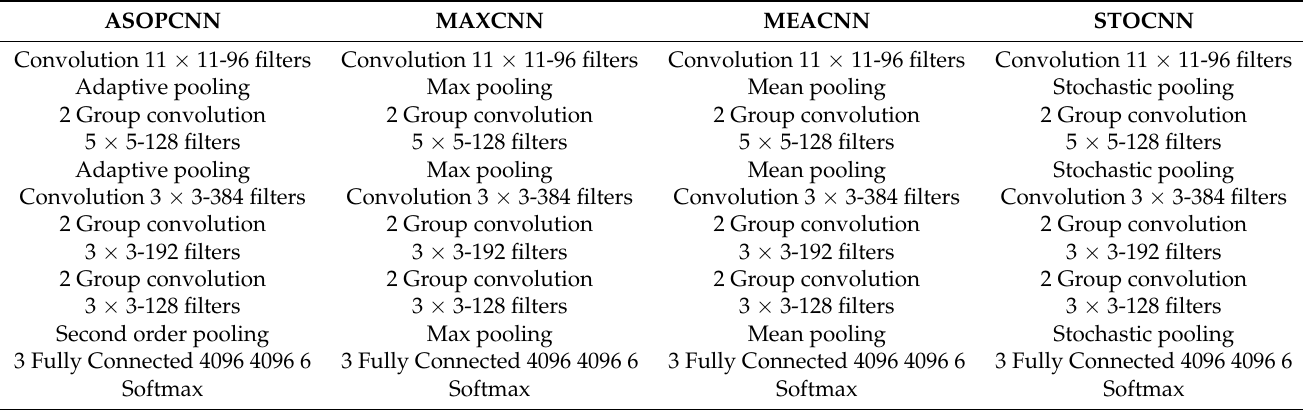
Table 2. Model structure